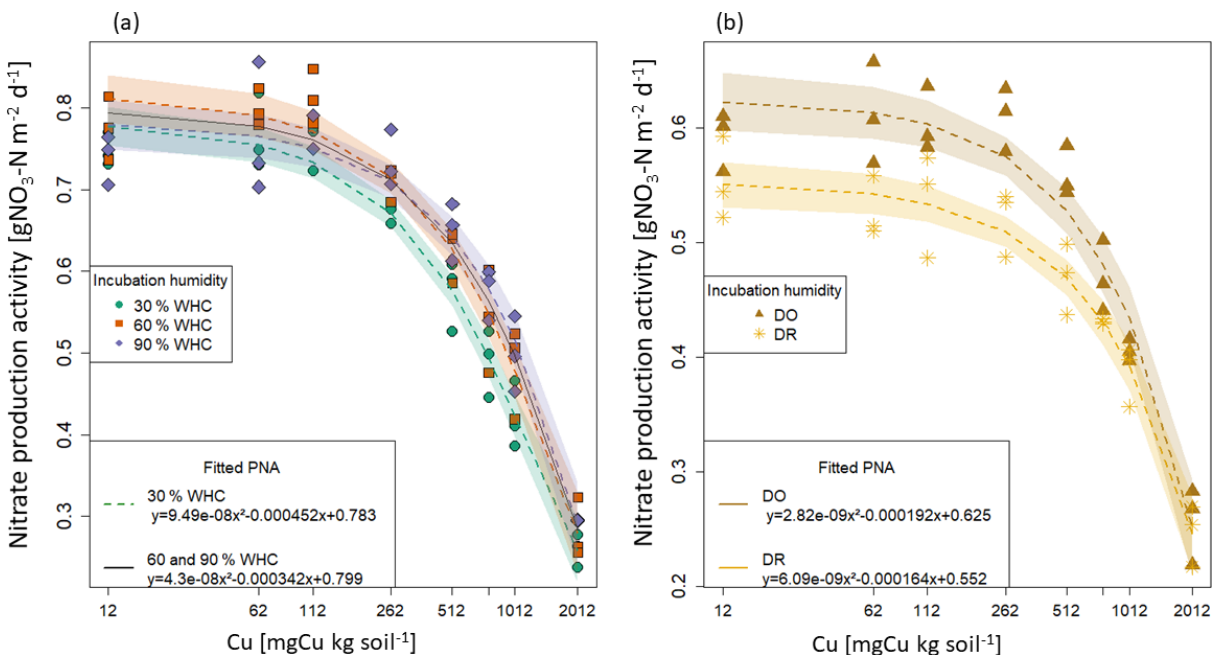
Figure 2. Fitted functions of potential nitrifying activities (PNA) against total soil copper concentrations [Cu] for each initial moisture incubation treatment. Points are the measured nitrate production and lines the fitted quadratic function with their 95% confidence interval. (a) Constant moisture treatments: the green circle is for 30% WHC, the red square for 60% WHC and the purple diamond for 90% WHC. The black line is the common fitting function used for 60% and 90% WHC moisture treatments. (b) Variable initial moisture treatments: the brown star is for Dry-Rewet (DR) and the yellow triangle for Dry-Only